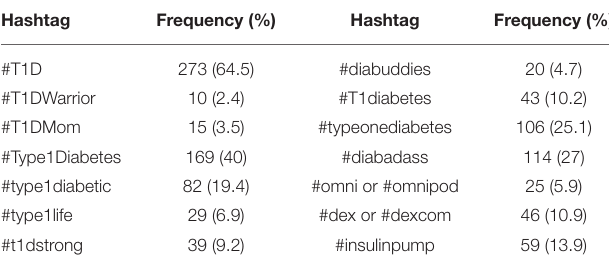
TABLE 1 | Hashtags in #t1dlookslikeme sample ( N = 423).